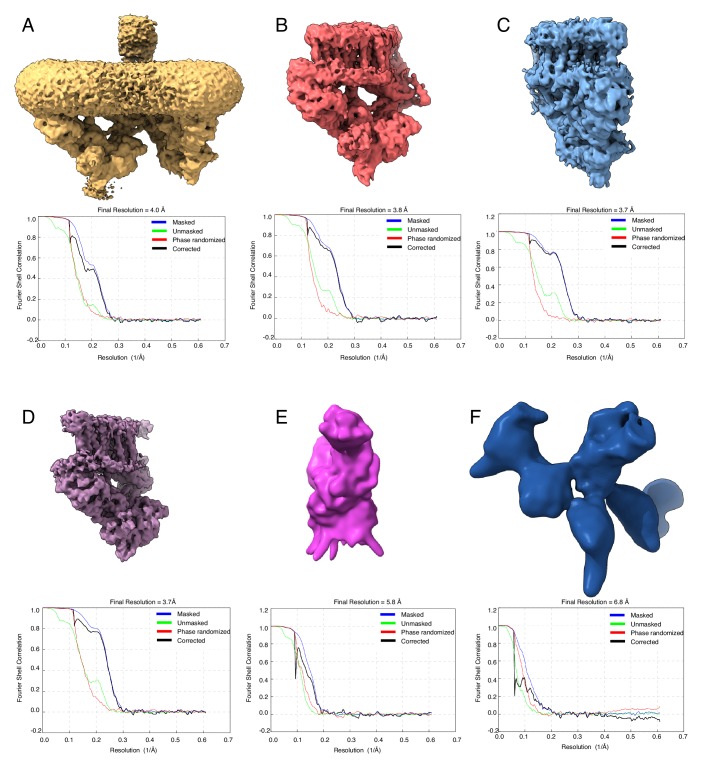
Consensus and focused refinements.(A) Consensus refinement map and FSC curve for the ESX-3 complex. Focused refinement maps and FSC curves for (B) the left protomer of the ESX-3 complex, (C) the right protomer of the ESX-3 complex, (D) a symmetry expanded protomer, (E) the periplasmic domain of EccB and (F) the lower ATPase domains of EccC. All maps are unsharpened and unmasked.